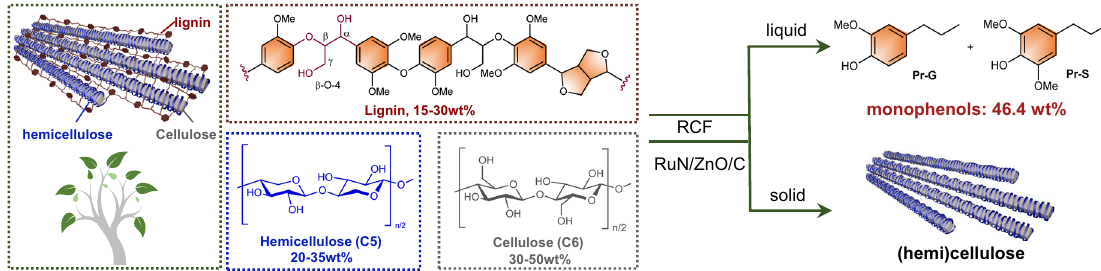
Fig. 1 | Route for reductive catalytic fractionation of lignocellulosic biomass. Representative structures of lignin, cellulose, and hemicellulose (left). A highly dispersed Ru catalyst (RuN/ZnO/C) is used for reductive catalytic fractionation